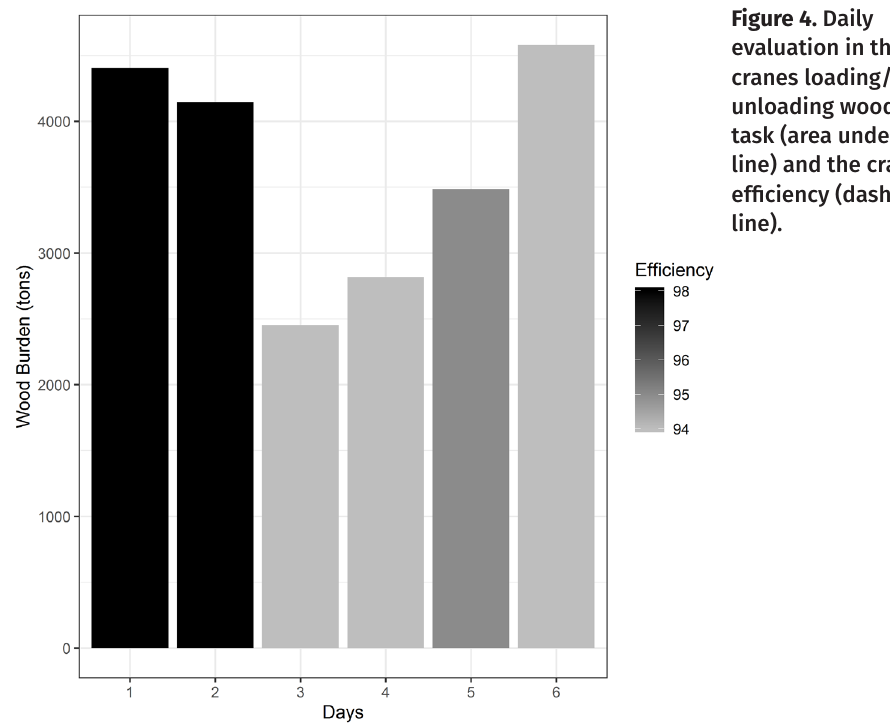
Figure 4. Daily evaluation in the cranes loading/ unloading wood task (area under the line) and the cranes efficiency (dashed